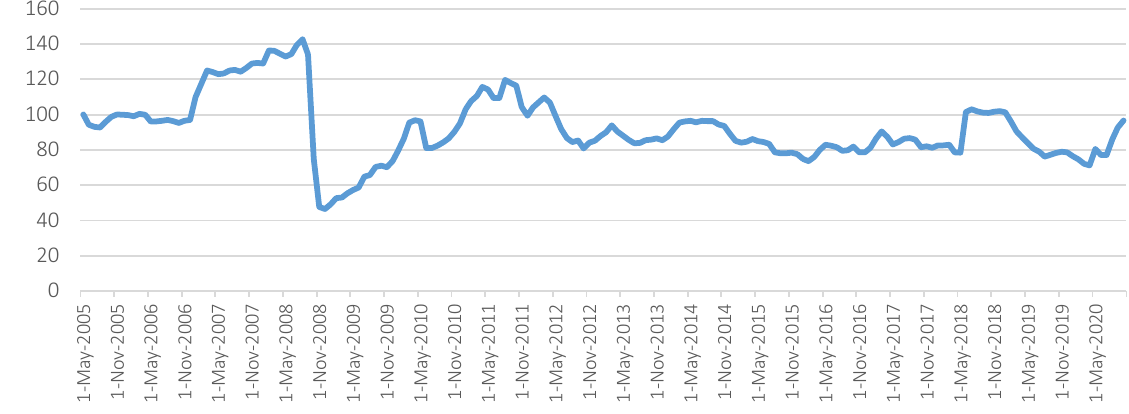
Figure 1. PCM price